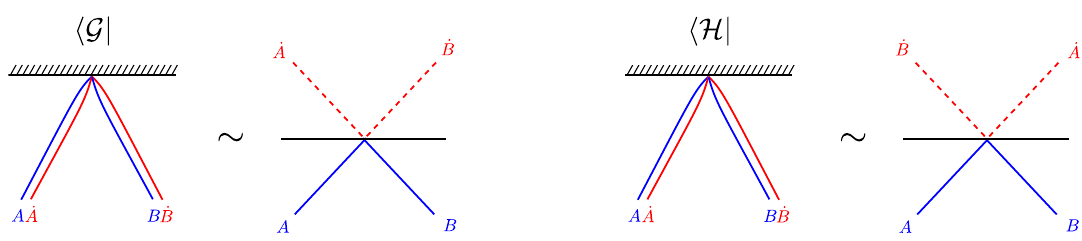
Figure 28 . The comparison of the matrix structures for the Giant Graviton form factor (left) and the hexagon form factor (right). The two are related by a swap of the dotted indices as shown in the (cid:12)gure. Because of this di(cid:11)erence, the matrix structure for the hexagon form factor does not admit a simple interpretation as an unfolded re(cid:13)ection